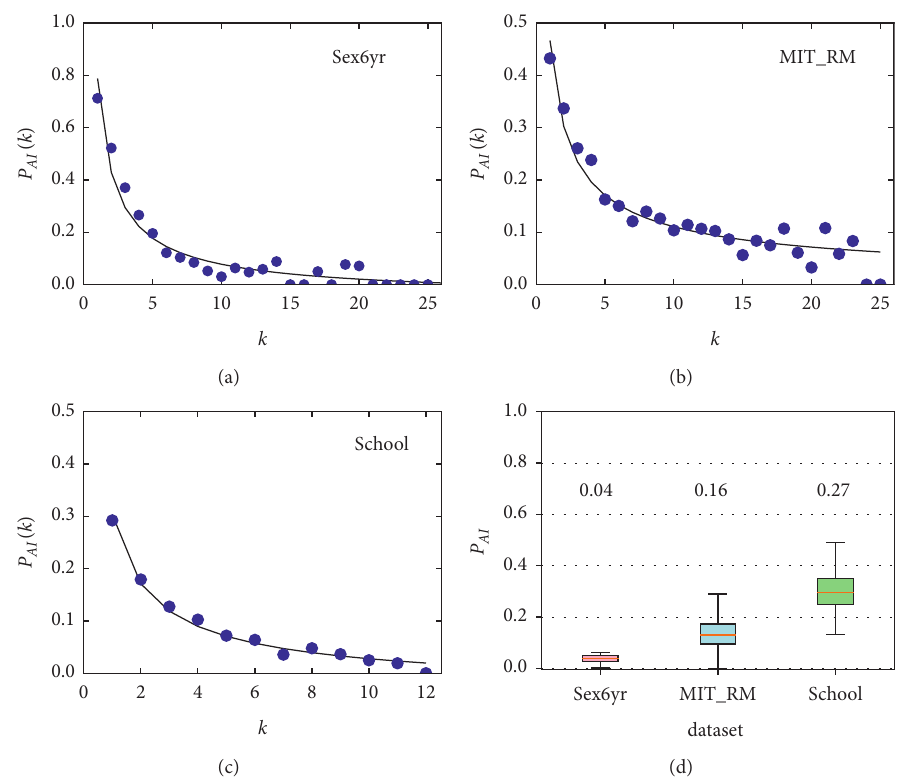
Figure 2: Transition probabilities between active state and inactive state as functions of the current degree k of the node, for the three empirical datasets. Solid lines represent the fitting curves: (a) P ( k ) � 0 . 33 k − 0 . 91 (School). (d) The firing rate P (c) P AI P are 0.04 (Sex6yr), 0.16 (MIT_RM), and 0.27 (School). IA